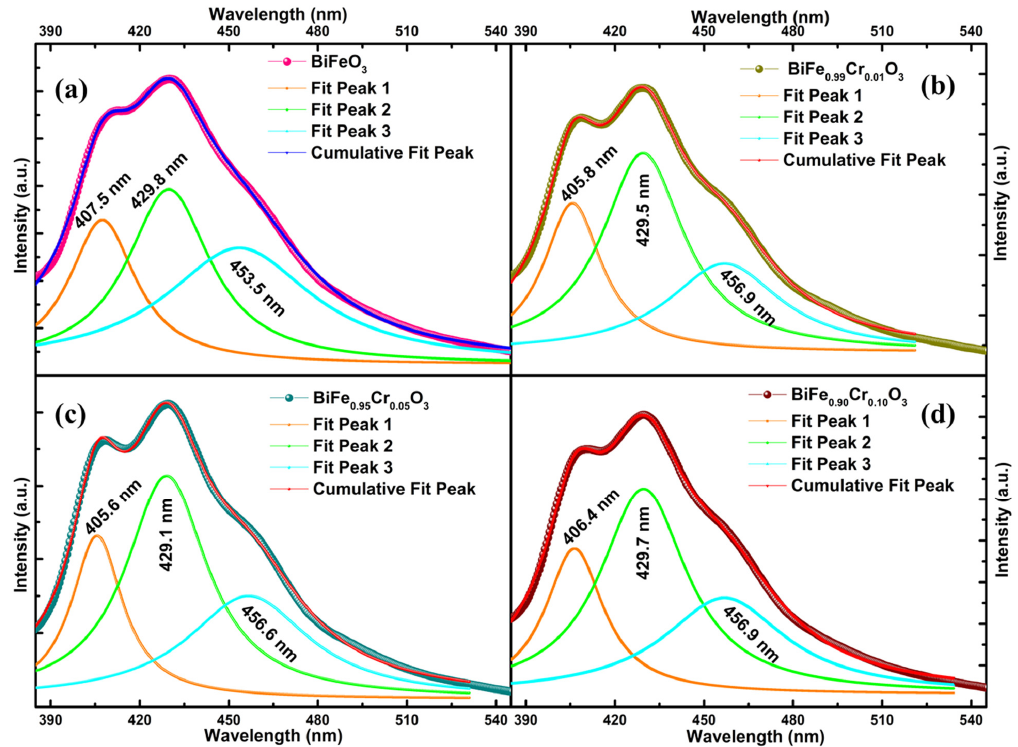
Figure 6. ( a – d ) Fitting of P–L spectra of BiFe 1 − x Cr x O 3 (0 ≤ x ≤ 10) nanoparticles in the range 300–600 nm with Lorentzian peak function.